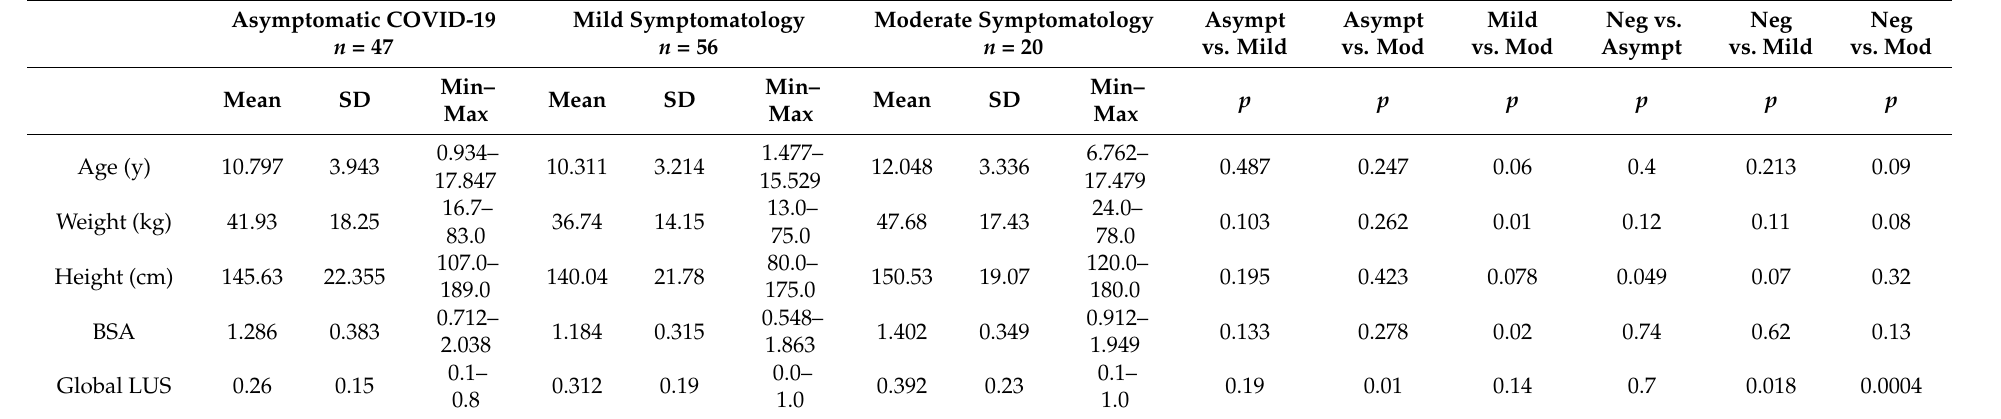
Table 3. Demographic and global LUS data of patients who experienced COVID-19 sorted by